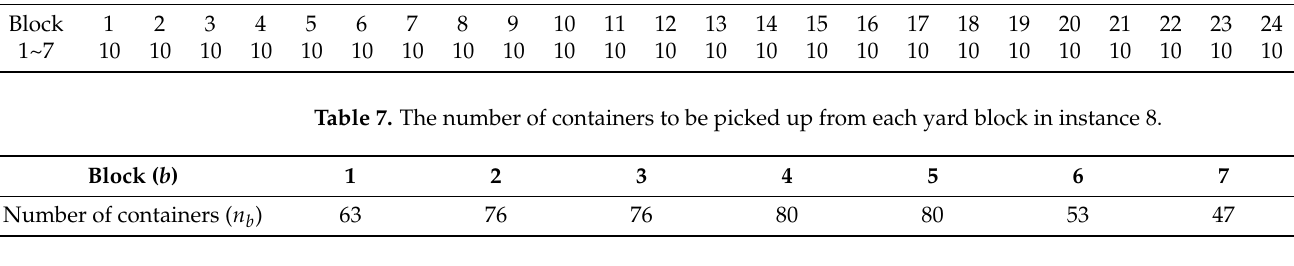
Table 8. The number of containers to be picked up from each yard block in instance